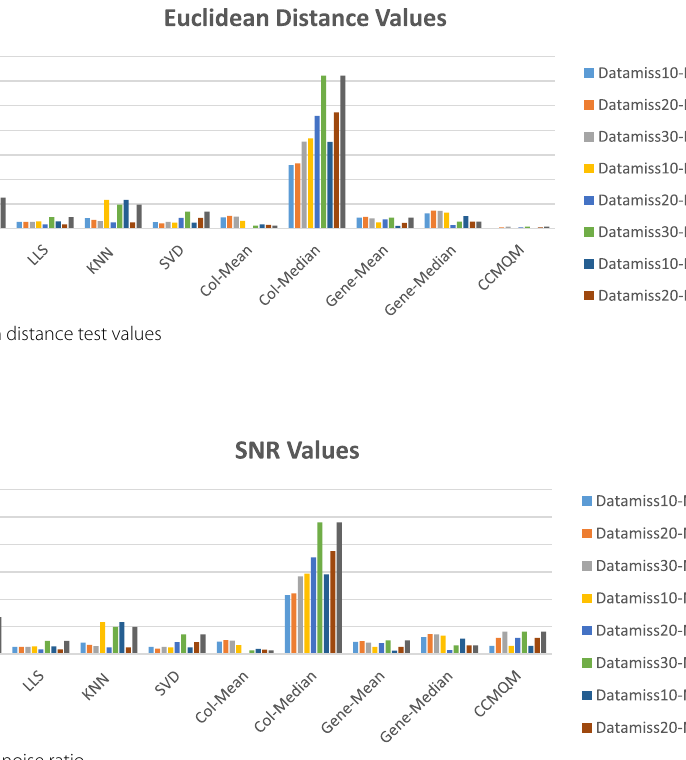
Fig. 5 Signal-to-noise